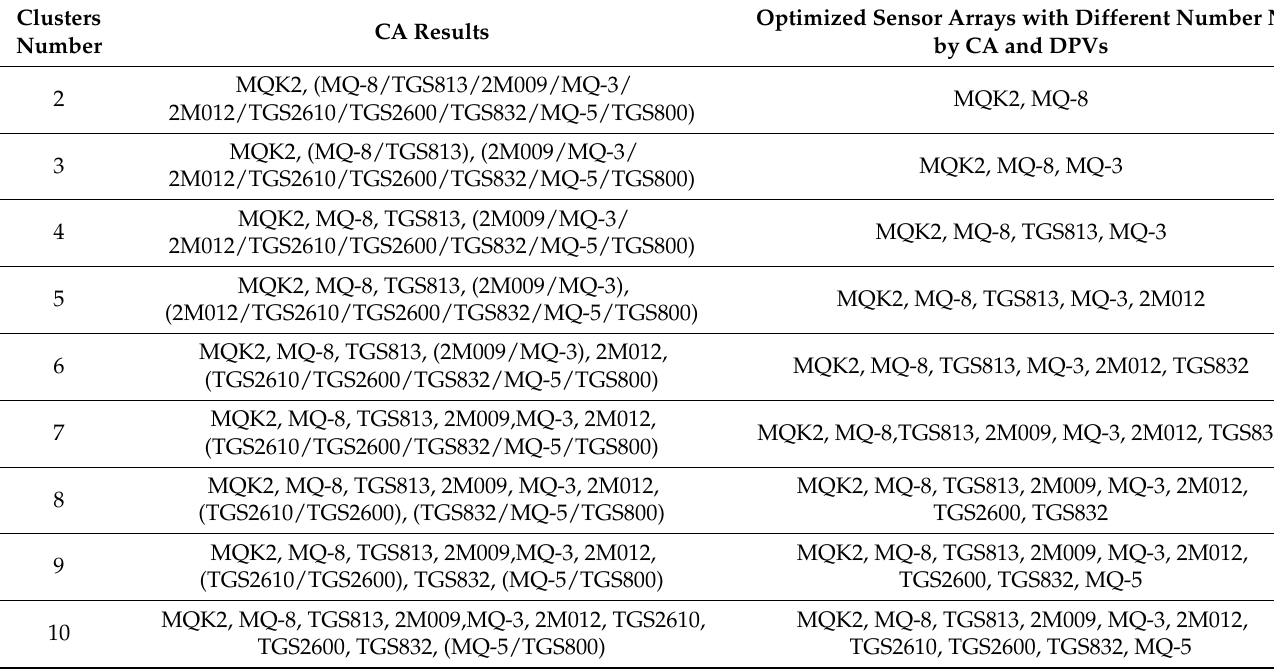
Table 7. CA results and optimized sensor array with different number N by CA and DPV.